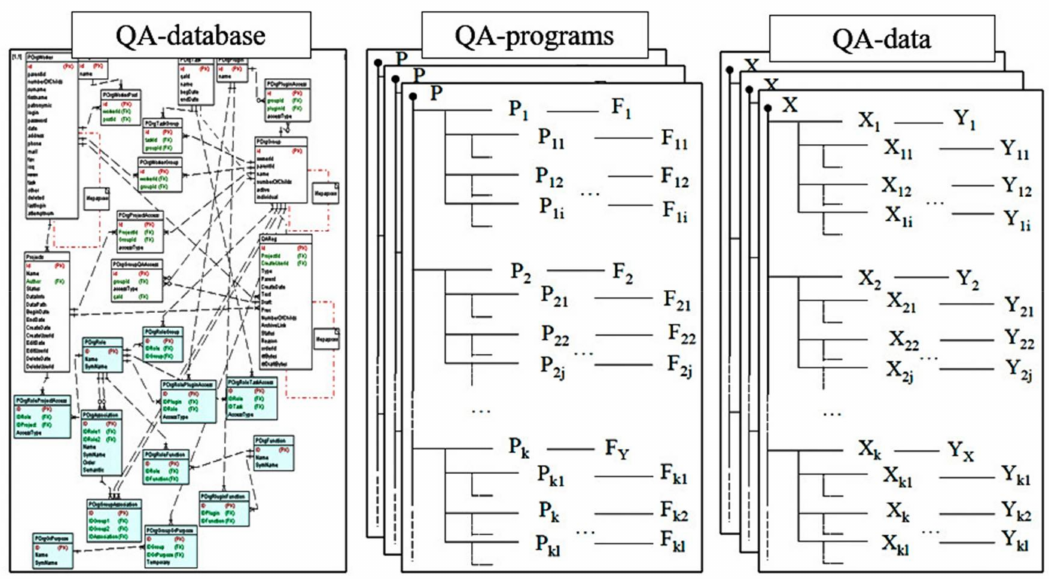
Figure 8. QA-nets of pseudo code programs